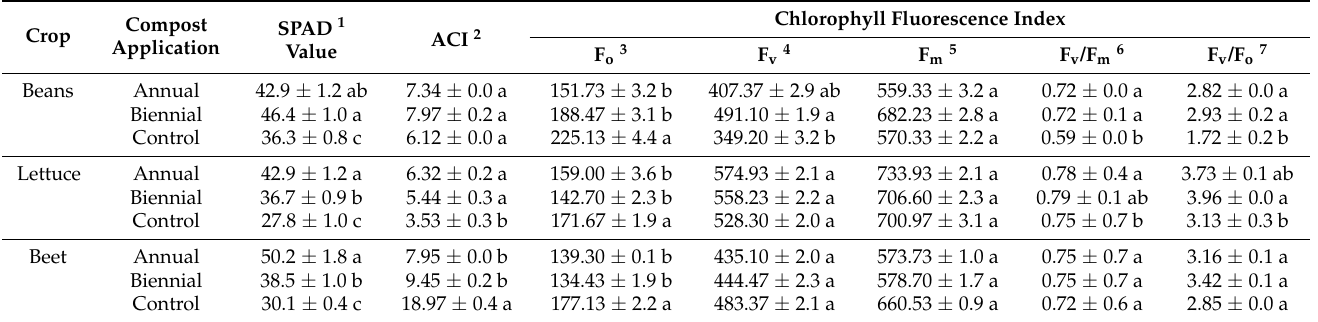
Table 5. Leaf pigmentation and plant photosynthetic efficiency indices as affected by frequency of application of municipal solid waste compost.